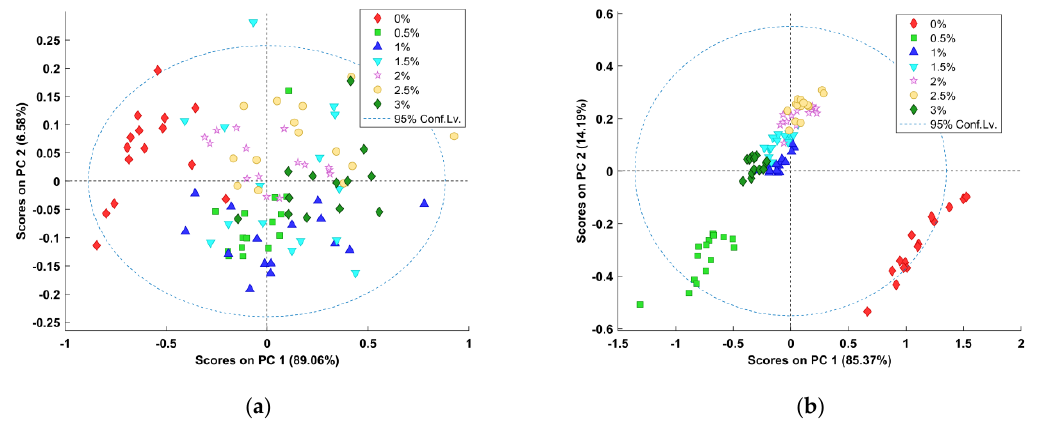
Figure 5. The principal component analysis (PCA) scores plot for the ( a ) electronic nose data and ( b ) NIRS